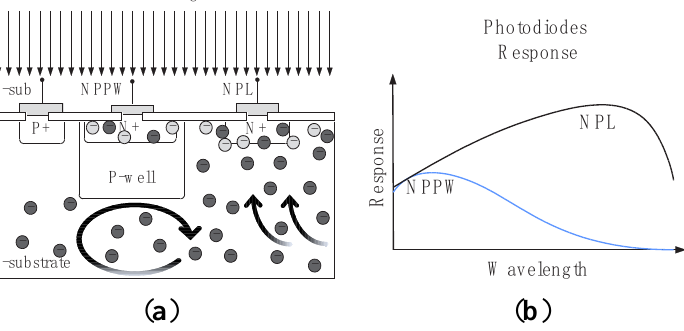
Figure 3. ( a ) A retrograde p-well can be used to shield substrate carriers; ( b ) The responsivity of the shielded pn-junction NPPW is sensitive to short (blue) light